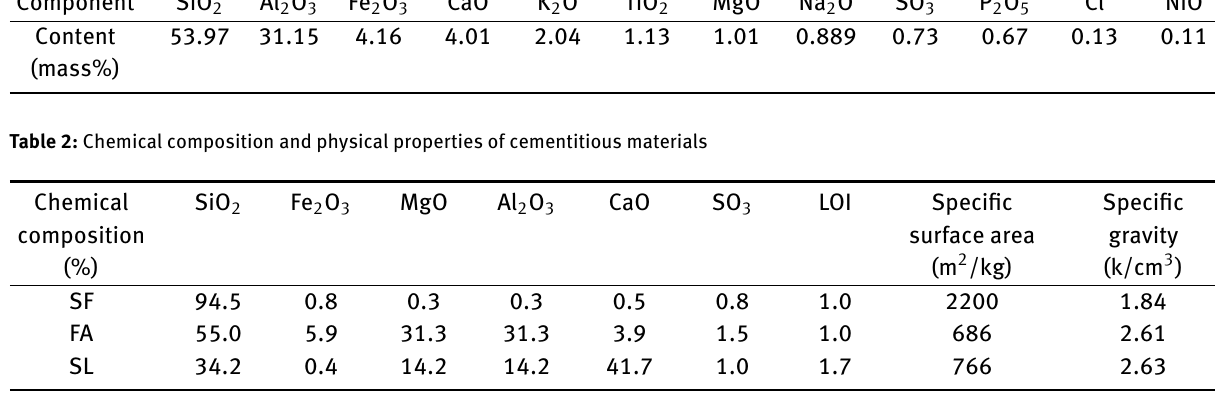
Table 1: Chemical composition of cement Component